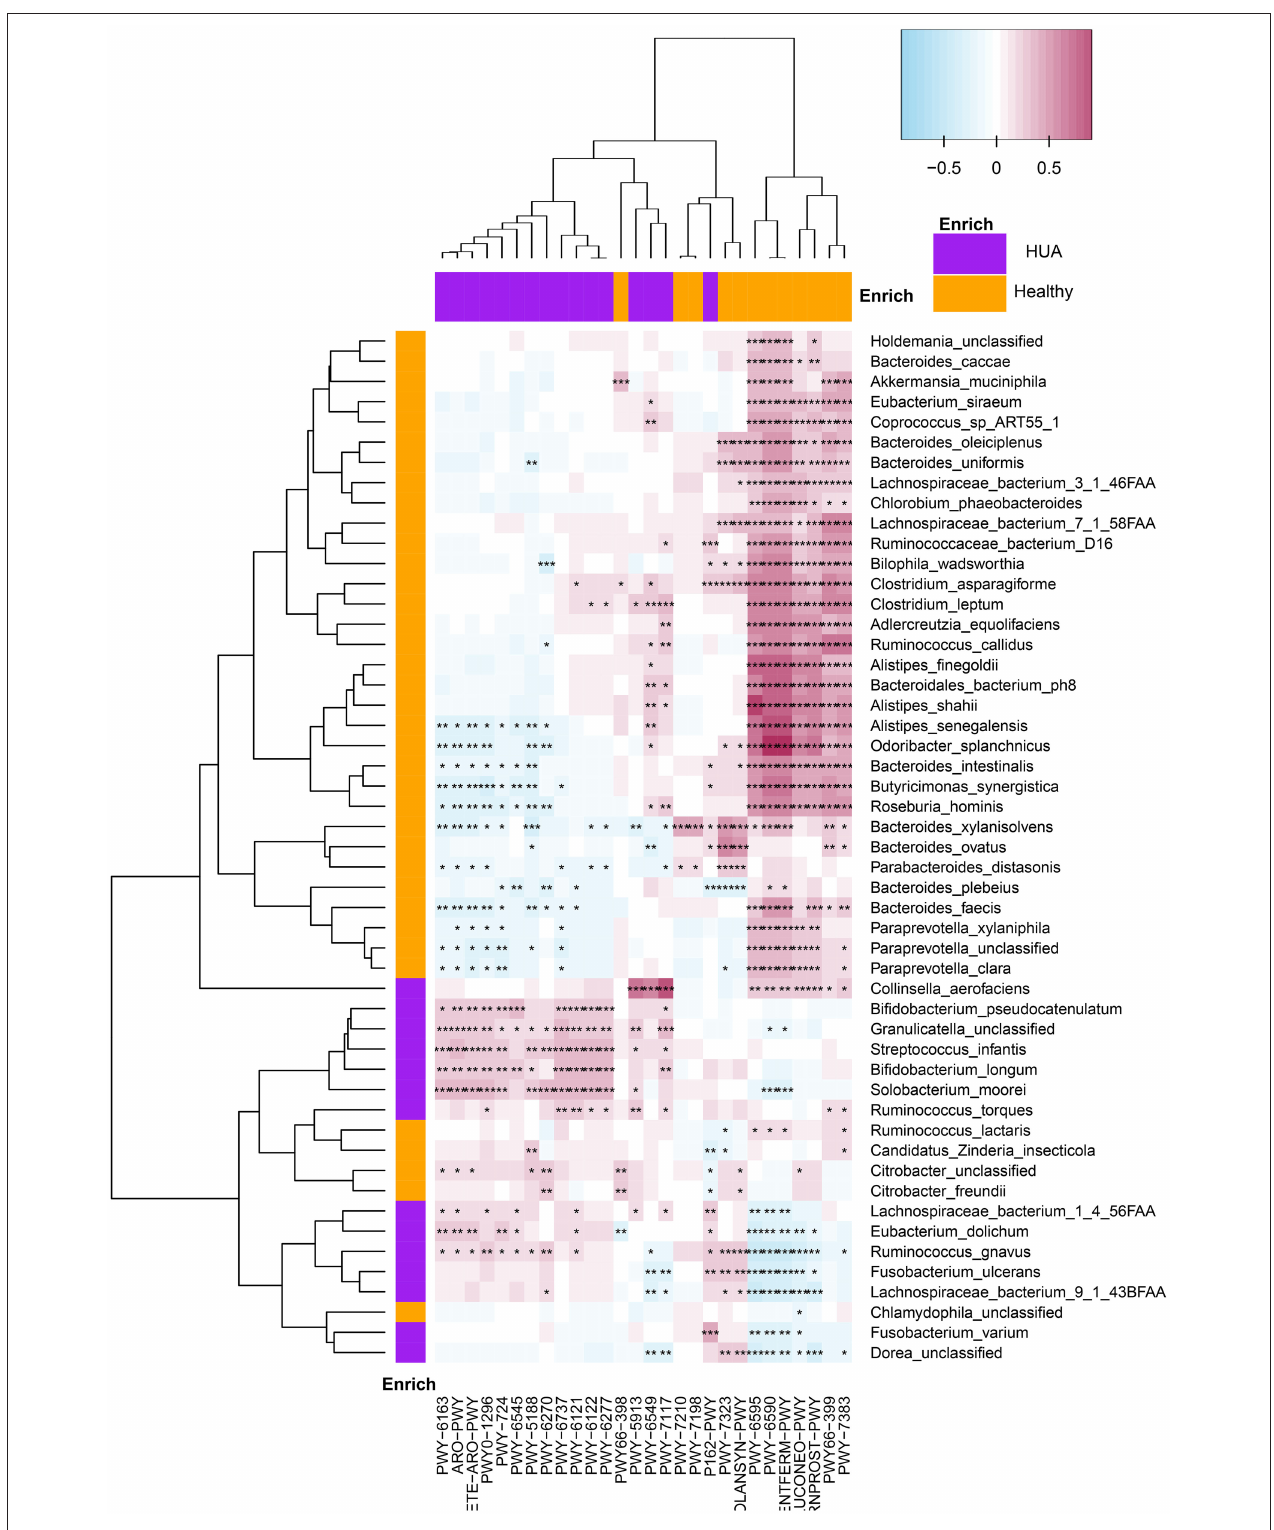
FIGURE 5 | Spearman’s correlation matrix for microbial pathways and bacterial species in HUA group and healthy controls. Different cell color represented for relative correlation type (purple: negative, red: positive). Cells with *, **, or *** asterisk represented P < 0.05, 0.01, or 0.001 respectively.